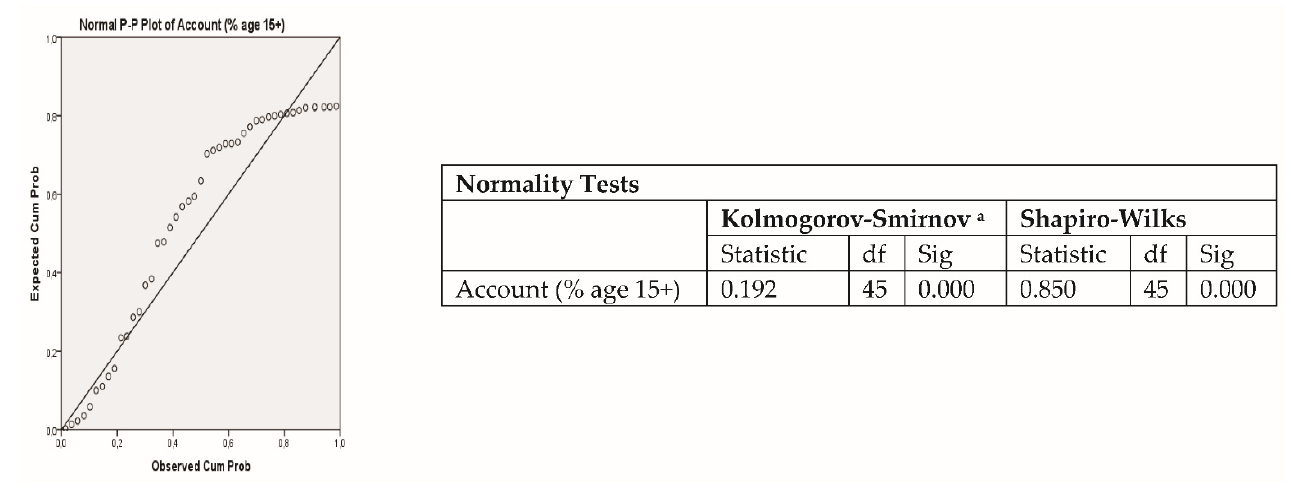
a Lilliefors Significance